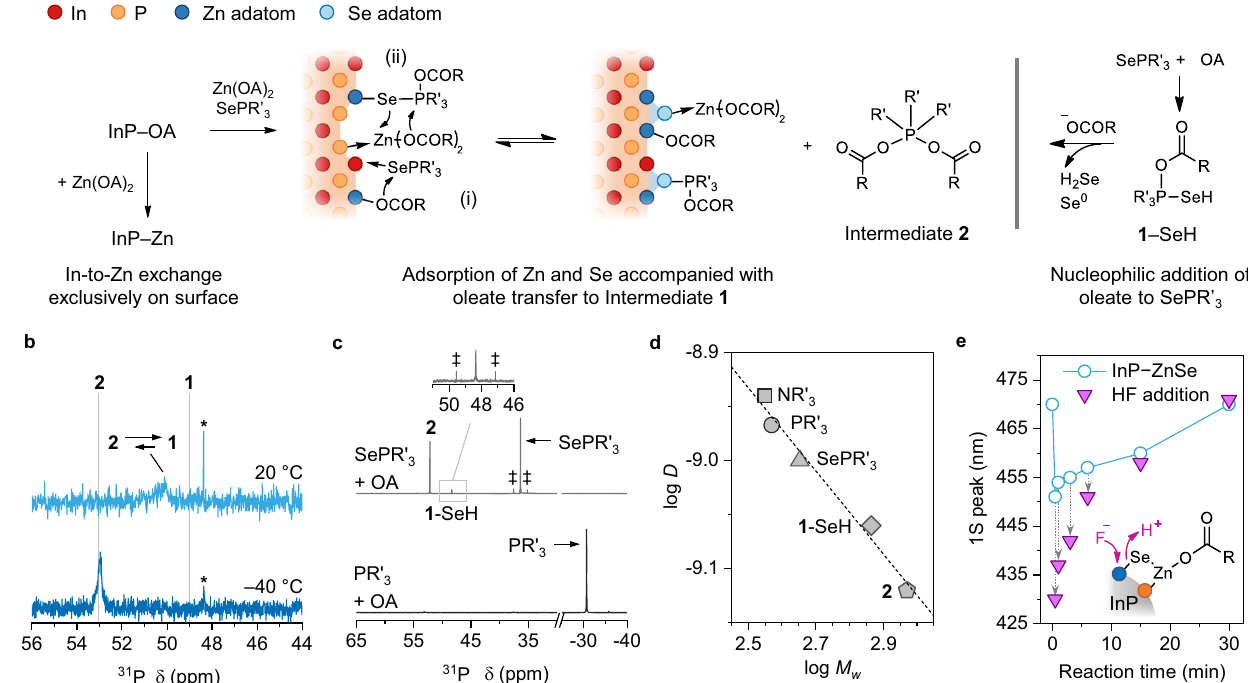
Fig. 2 | FormationofZn – Selinkage onoleate-capped InP NCs.a Introduction of Zn from zinc oleate [Zn(OA) 2 ] to InP – OA through the In-to-Zn surface exchange (InP – Zn)andformationofZn – SelinkageonInP – OAinthepresenceofZn(OA) 2 and SePR ’ 3 (InP – ZnSe).The latter proceedstogether with adsorbed speciesbetween(i) an exchanged oleate-capped Zn adatom and datively bound SePR ’ 3 or (ii) datively bound Zn(OA) 2 and Intermediate 1 that produces pentacoordinate dioleoyloxy- trioctylphosphorane (Intermediate 2 ). This compound is separately prepared by nucleophilic addition of oleate to SePR ’ 3 , as shown on the right. b 31 P NMR spectra of InP – ZnSe (reacted at 200°C) recorded at 25°C (top, light blue) and – 40°C (bottom, blue).Asterisk (*) indicates OPR ’ 3 . c 31 P NMR spectra ofreaction products